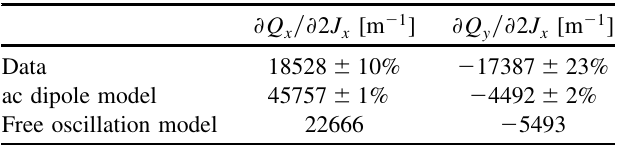
DIRECT AMPLITUDE DETUNING MEASUREMENT . . TABLE II. Octupolar term given by the fit results from data and MAD-X tracking with ac dipole and octupolar term from PTC which assumes free oscillations. The errors given in this table represent the fit errors. The uncertainties from coupling derived in Sec. VIII A are not included.